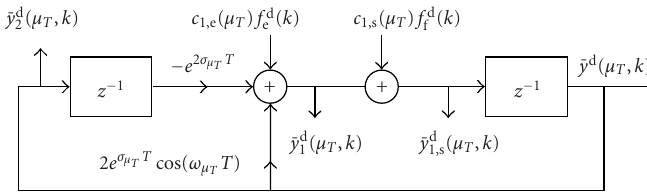
Figure 3: Recursive system realization of one mode of the transversal vibrating